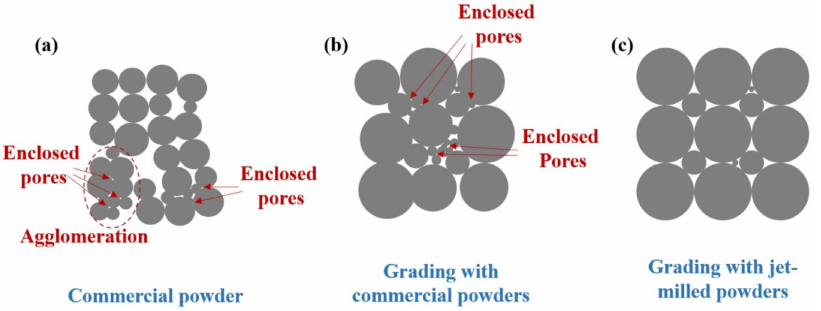
Figure 12. Schematic diagram of the accumulation of ( a ) WY–050, ( b ) WY–G, and ( c ) WM–G